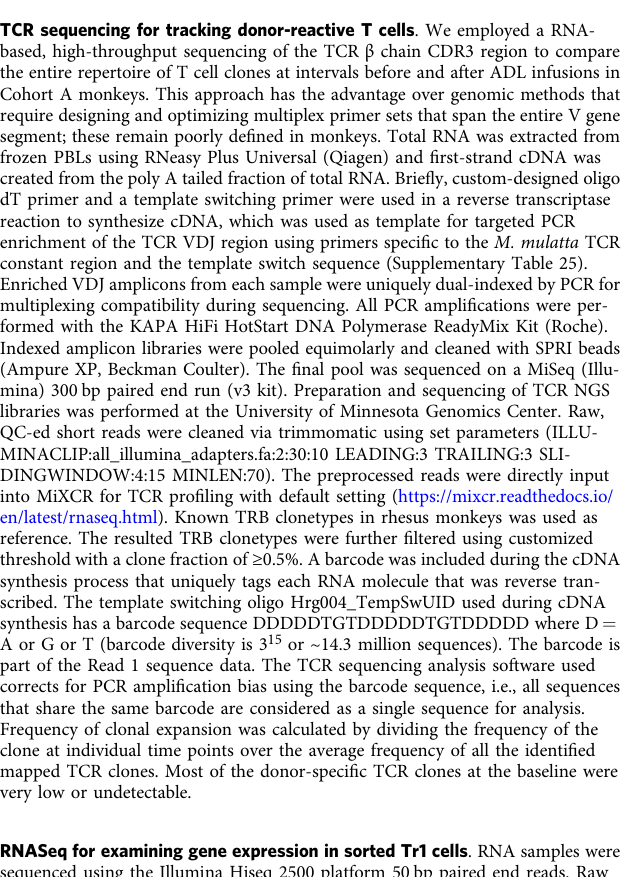
Table 24) using the Immune Epitope Database Analysis resource.